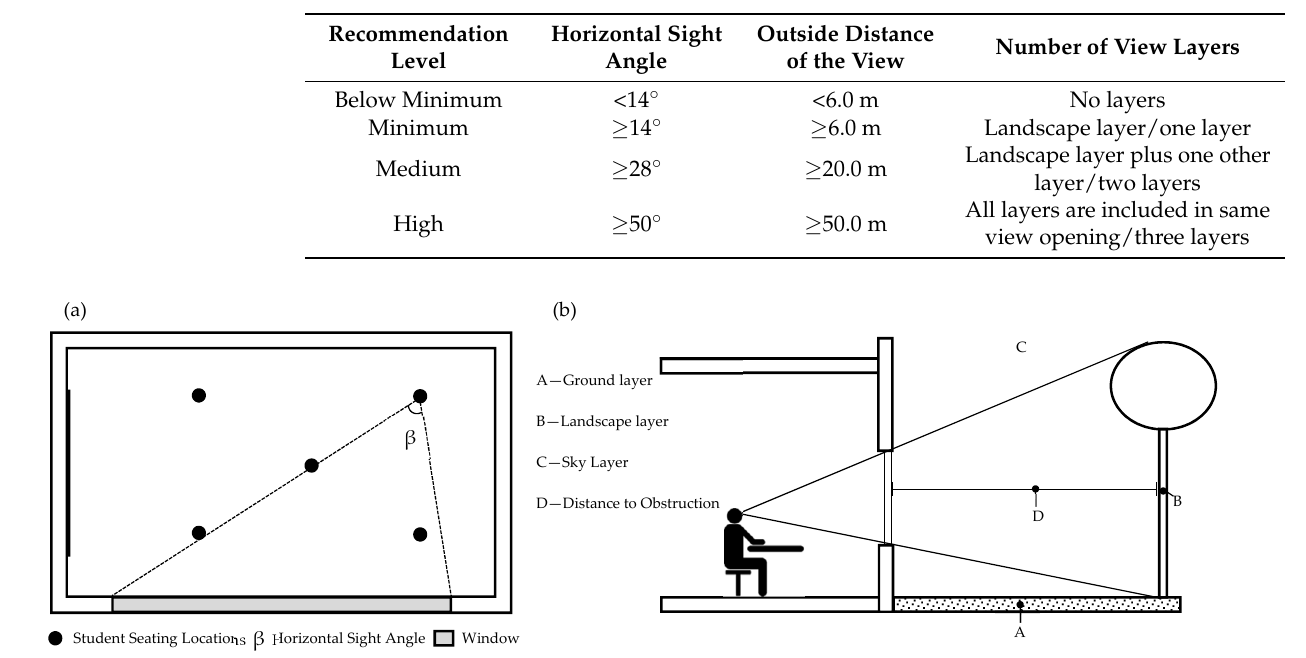
Figure 3. ( a ) Example Classroom Floor Plan; ( b ) Example Section Cut for View Metrics.